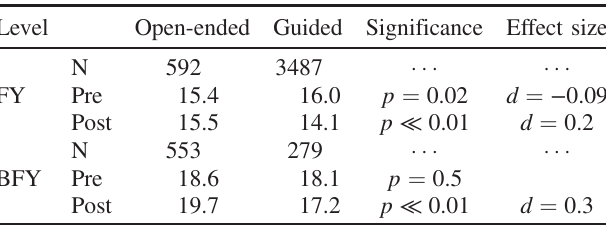
TABLE IV. Overall E-CLASS scores (points) for students in courses using open-ended activities and those using only tradi- tional guided labs in the FY and BFY student populations separately. Significance indicates the statistical significance of the difference between students ’ scores in the open-ended and guided lab only